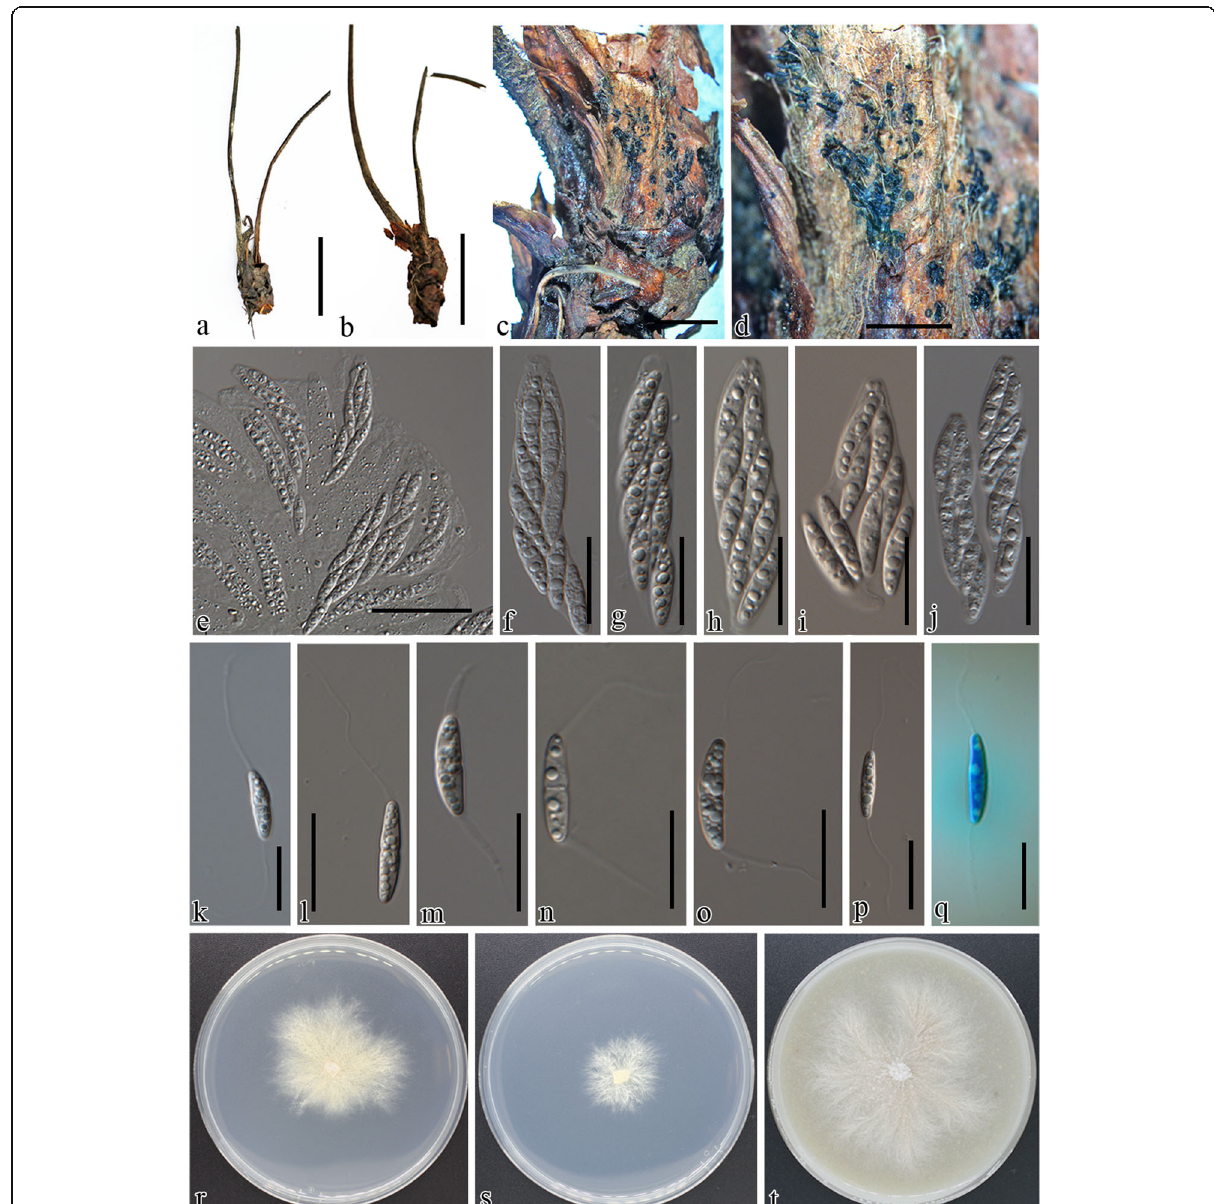
Fig. 4 Morphology of Paragnomonia fragariae AG16076 (BPI 919211 and living culture CBS 143831). a-d Infected petioles of Fragaria sp. e-j Asci k-q Ascospores. r 7-d-old cultures on PDA. s 7-d-old cultures on MEA. t 7-d-old cultures on V8A. Scale bars: a, b = 2 cm, c,d = 1000 μ m, e = 30 μ m, f-j = 16 μ m, k,p,q = 18 μ m, l – o = 20 μ